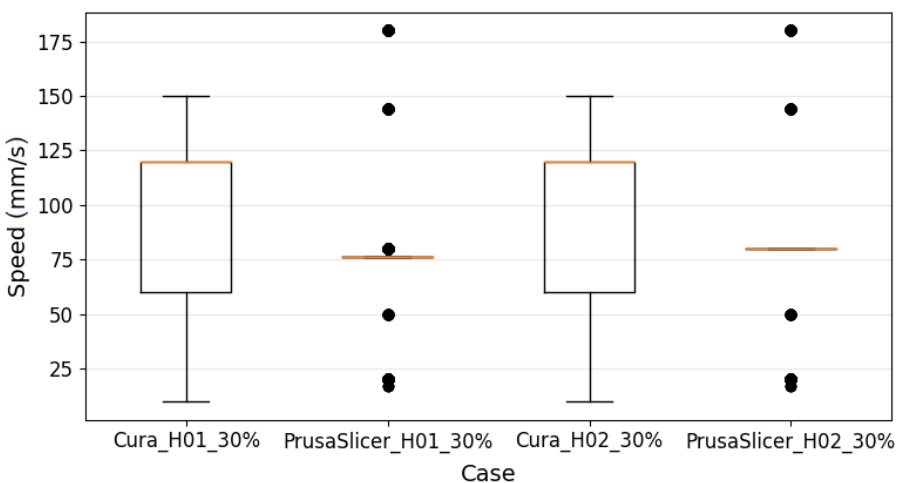
Figure 3. Speed of the print head. All box plots in the paper make use of circles and dots that respectively mark the outliers and extreme outliers. The boxes are bounded with the first and third quartiles. A detailed description regarding the visualized parameters can be found in the present section.